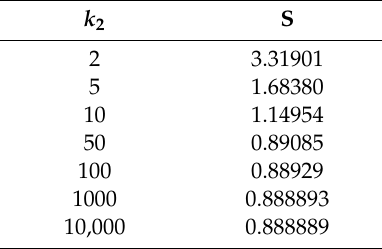
Figure 8. Concentration profiles of the general case of a parallel reaction system with parameters: k 1 = 1, k 2 = 2, 10 and 50, K 1 = 10 and K 2 = 2. Table 2. The sum of squared residuals of the general case of parallel reaction system compared to the special case with di ff erent values of k 2 ( k 1 = 1, K 1 = 10 and K 2 = 2).